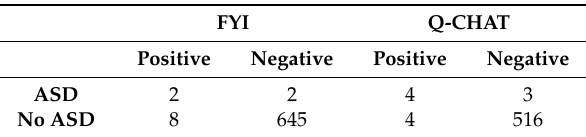
Table 5. Confusion matrix.